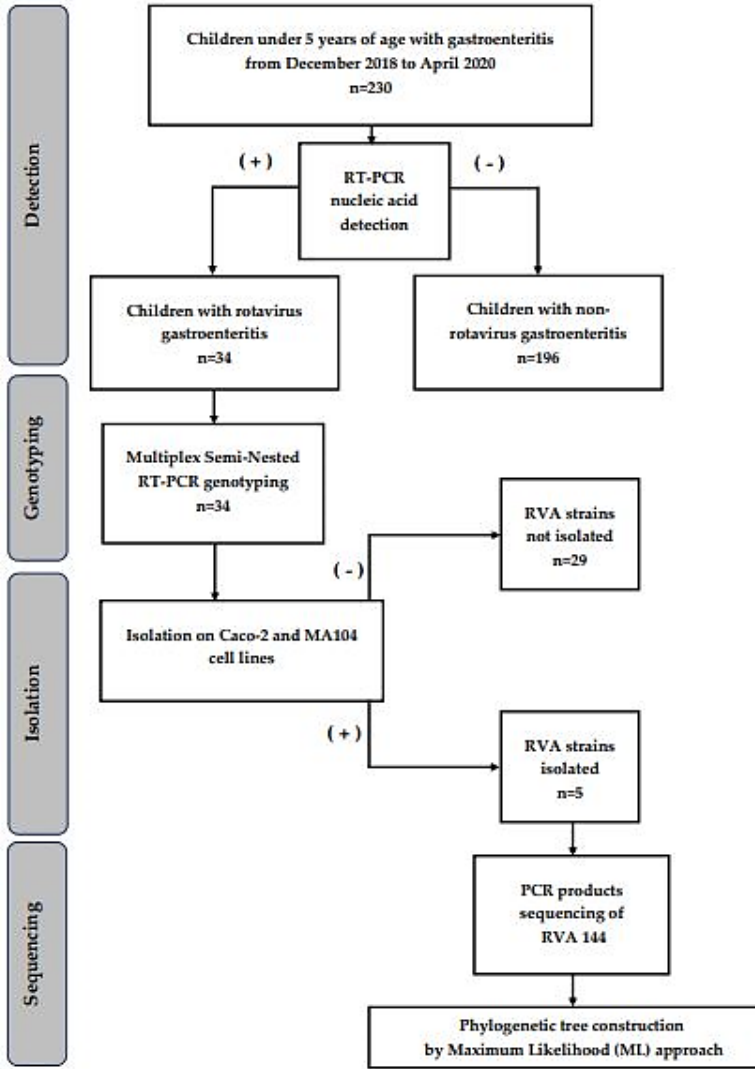
Figure 1. Flow chart summarizing the cross-sectional study of rotavirus cases among children with gastroenteritis in two Egyptian University Hospitals.